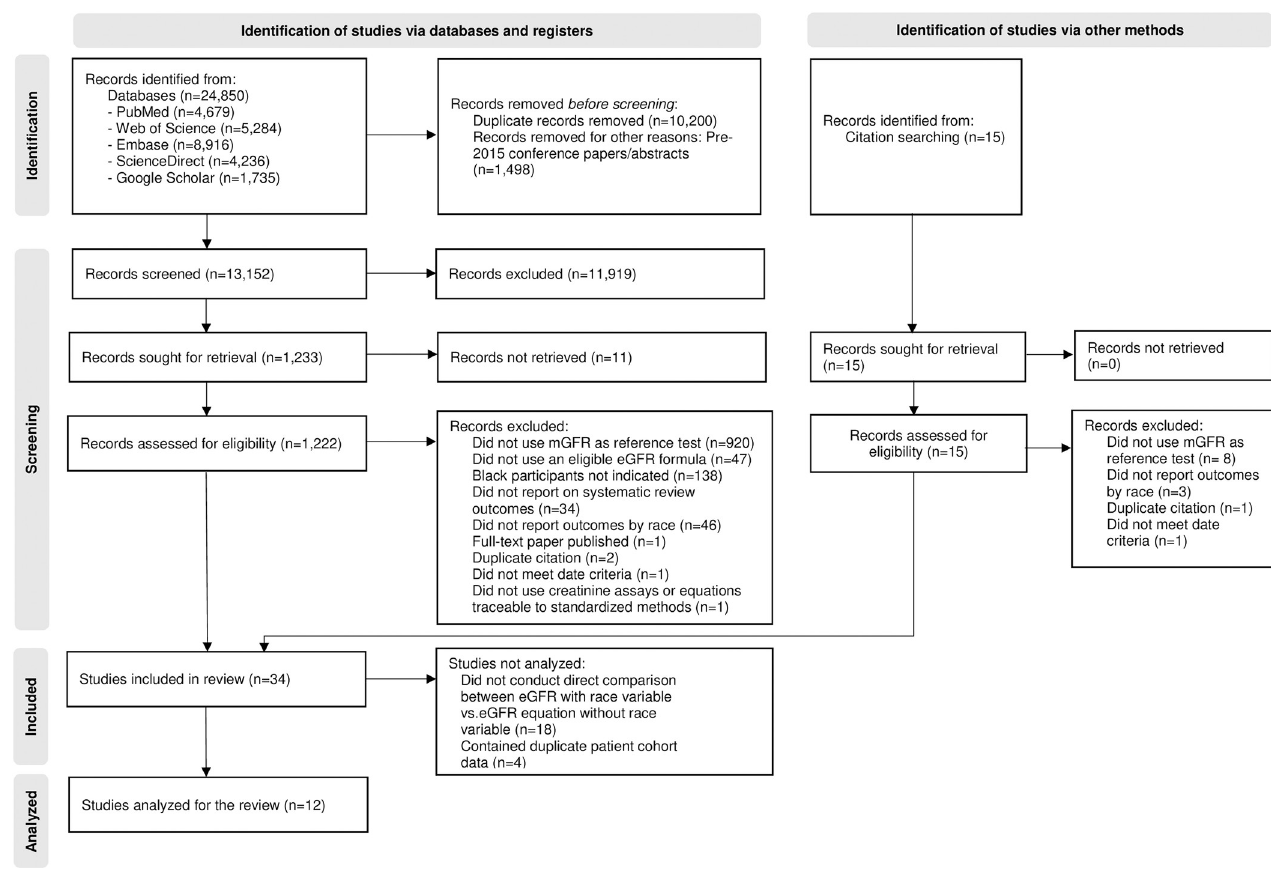
Fig 1. Flow diagram of study search and selection